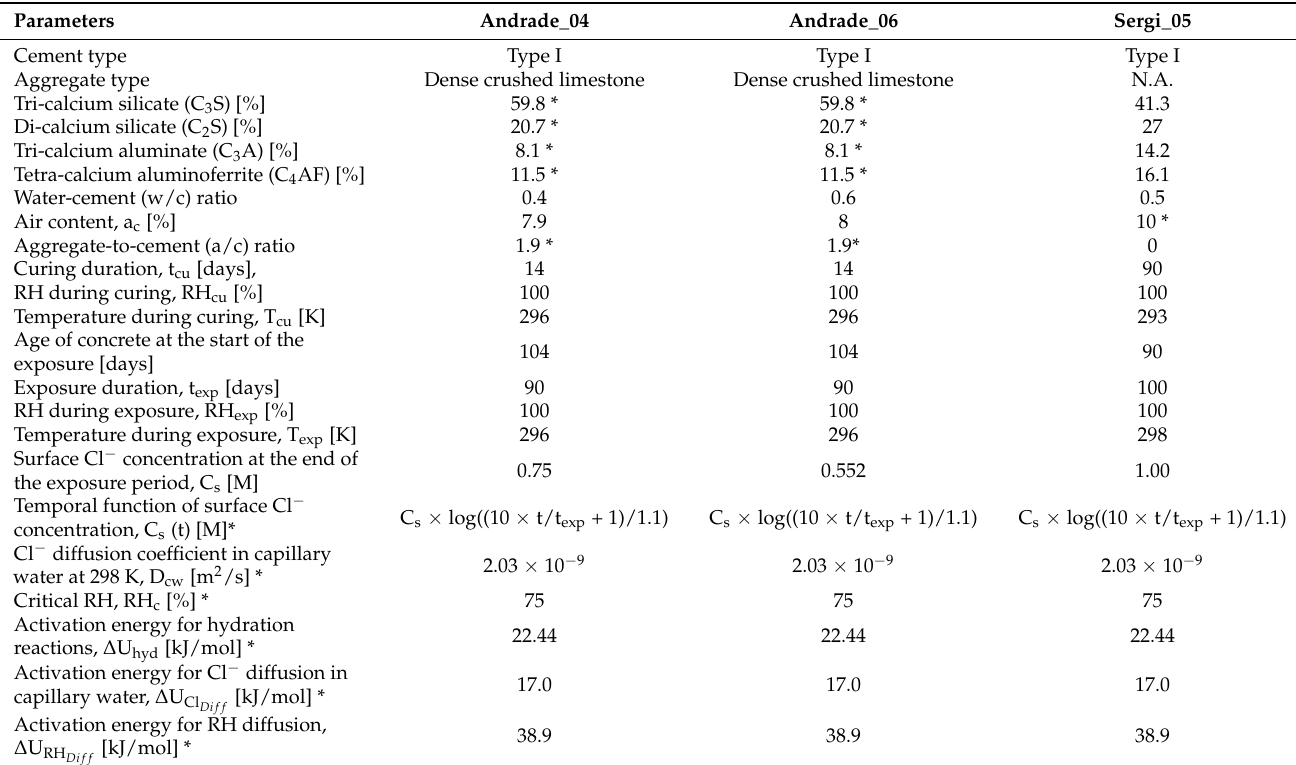
Table 4. Parameters used for validation study.